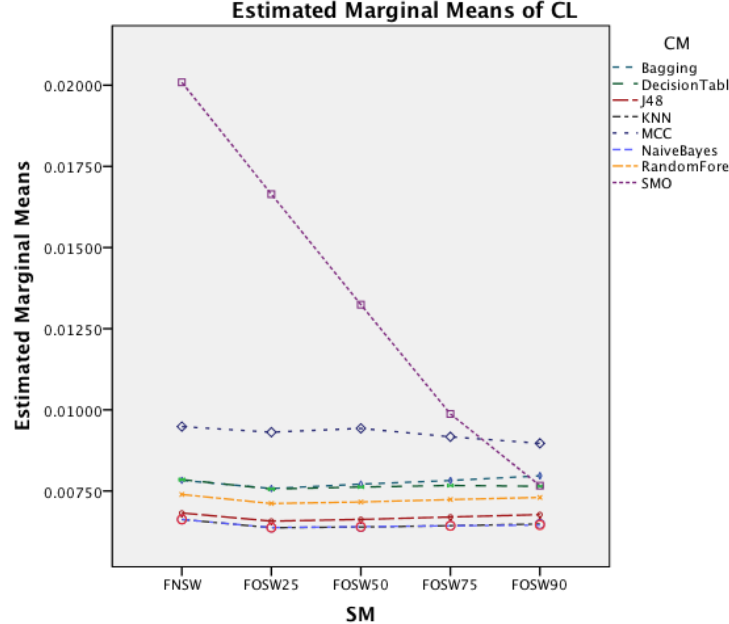
Figure 18. Two-way interaction effect for SM and